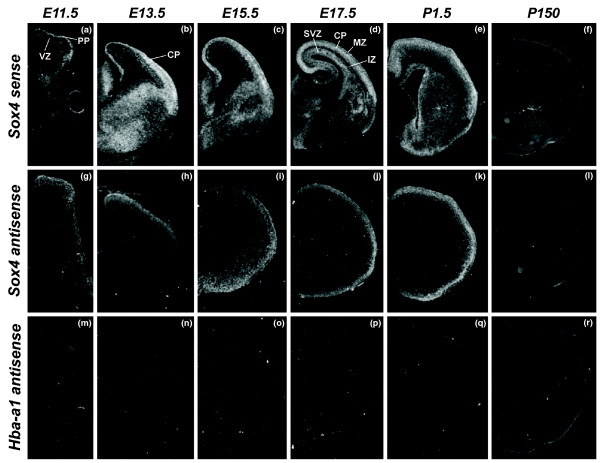
ISH analysis of Sox4 transcripts in E11.5 to P150 mouse brains. (a-f) Expression of the sense transcript for Sox4. (g-l) The expression of the antisense transcript for Sox4. (m-r) Hba-a1 antisense expression (negative control). All micrographs were taken from coronal sections. CP: cortical plate; IZ: intermediate zone; MZ: marginal zone; PP: primordial plexiform layer; SVZ: subventricular zone; VZ: ventricular zone.